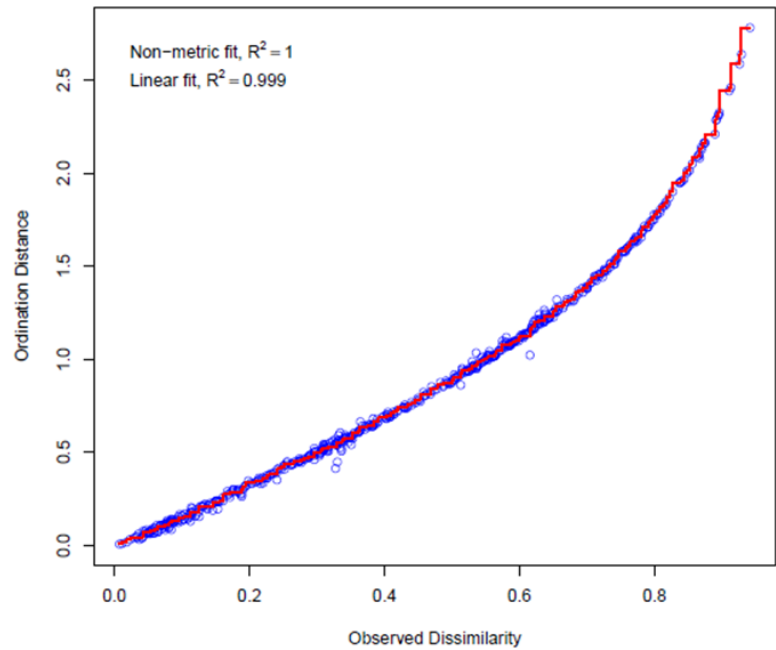
Figure 12. Shepard plot.